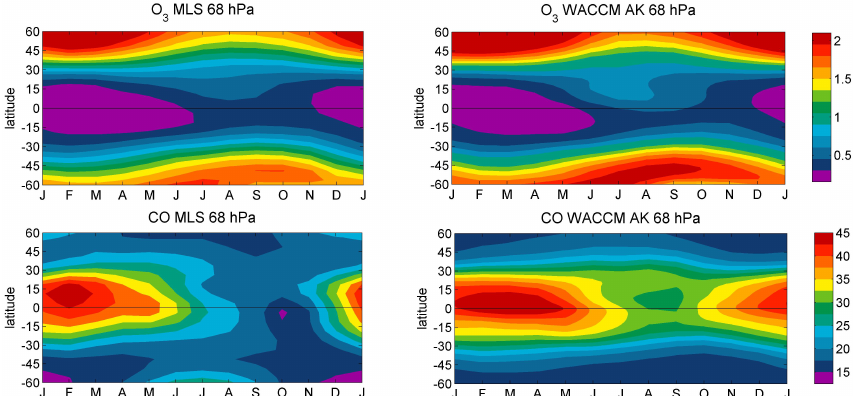
Fig. 5. Mean seasonal cycles of ozone (ppmv, upper panels) and CO (ppbv, lower panels) in MLS (left) and WACCM (right) at 68hPa. MLS averaging kernels have been applied to WACCM